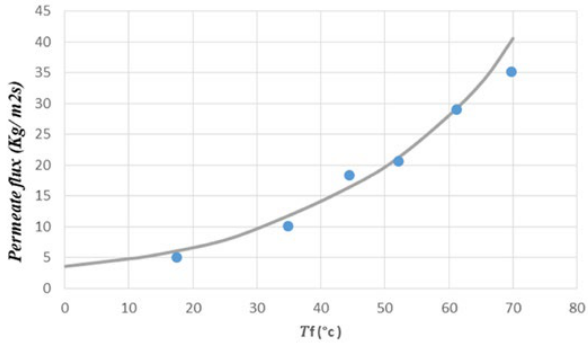
Fig. 8: The model validation with Khayet’s experimental data.